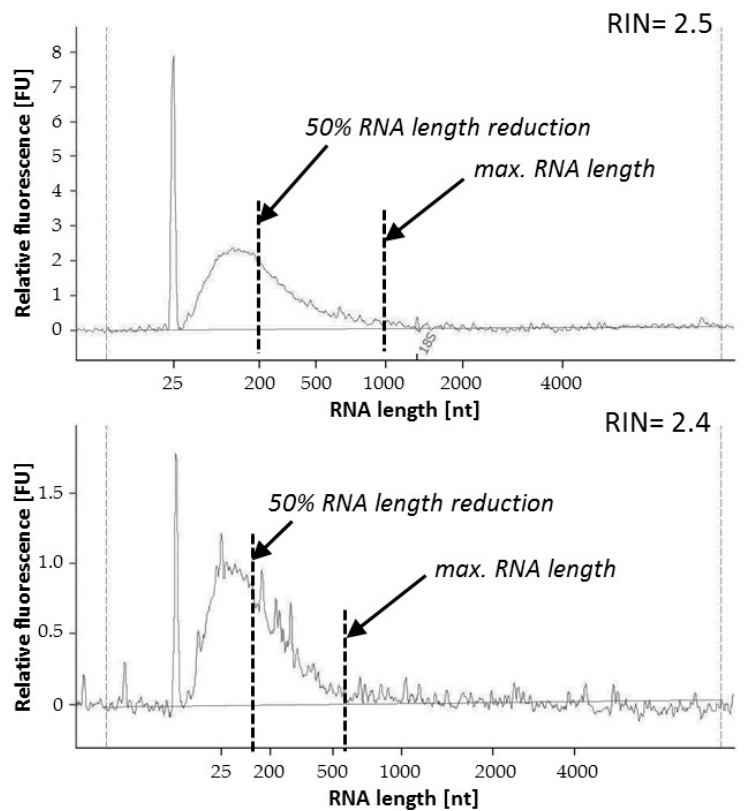
Figure 1. Evaluation of the extent of RNA fragmentation from FFPE tissue samples measuring the area under the curve from Agilent Bioanalyzer. Two values were defined: maximal RNA length and the 50% RNA length calculated as a 50% reduction of the area under the curve. RIN: RNA integrity number; FFPE: formalin-fixed paraffin-embedded specimens. nt: number of nucleotides; FU: fluorescence unit.